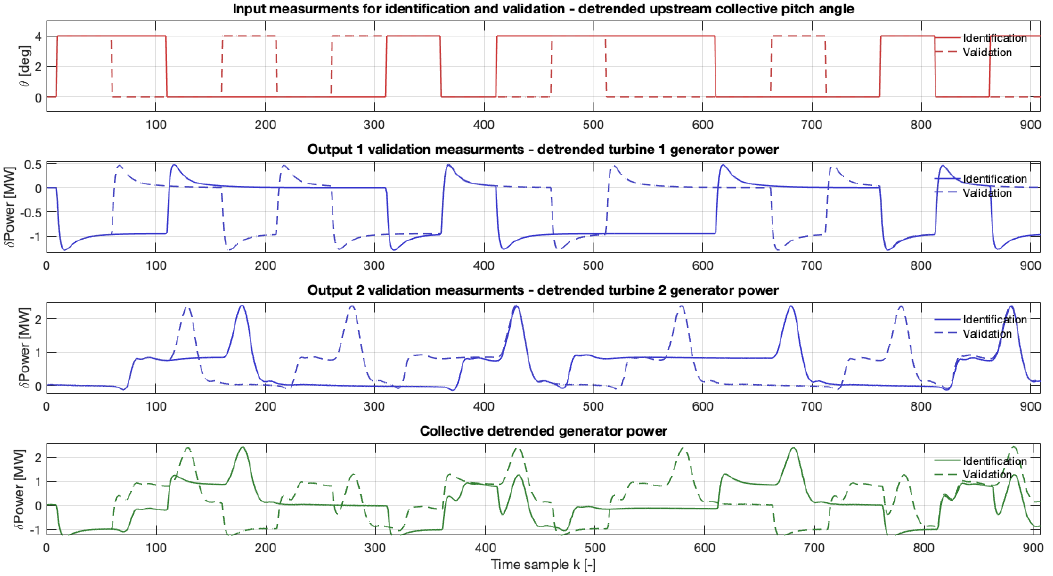
Figure 1. Input–output information for system identification ( solid line ) and validation ( dashed line ). Input data corresponds to the collective pitch blade angle of the upstream turbine ( in orange ) and output data are the generator powers of both upstream and downstream turbines ( in blue ). The last plot depicts the power gains and losses of the collective power throughout the simulations ( in green